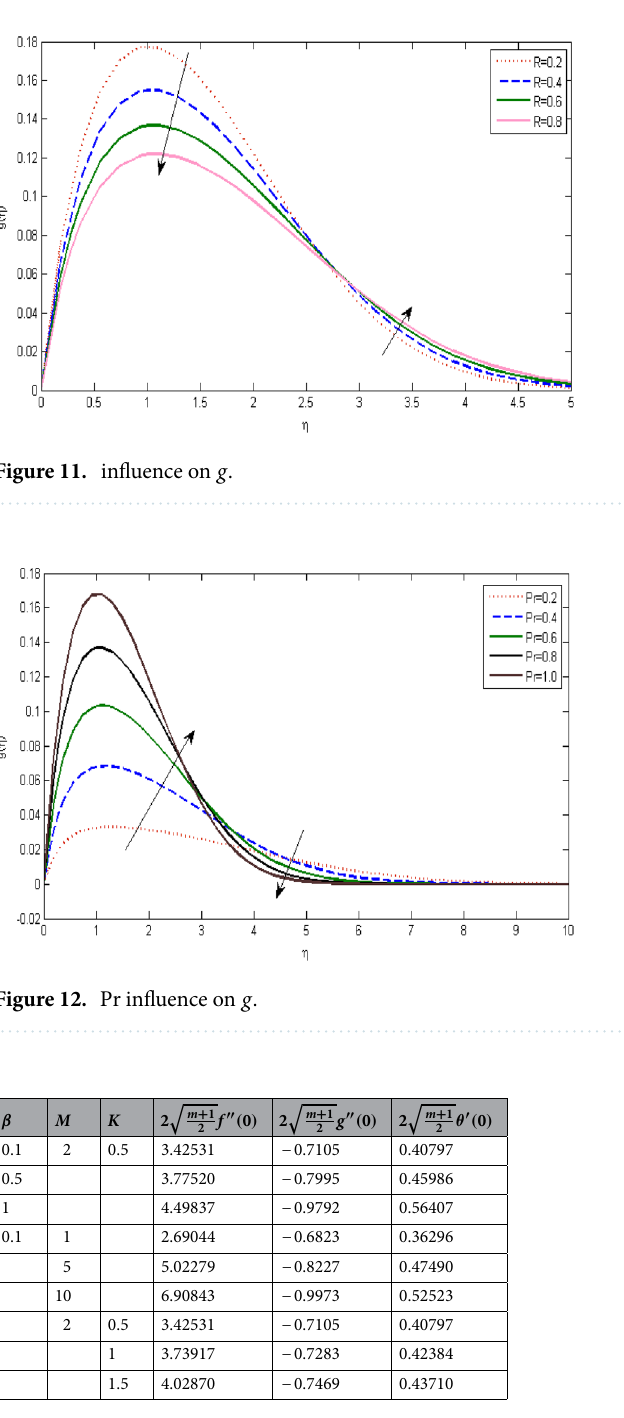
Table 2. The skin friction coefficient, Local Nusselt number, and Local Sherwood number alterations for a constant parameters of Pr = 0.71, c = 0.5, Nb = 0.5, Nt = 0.1, Le = 0.5, R = 0.1, Q =